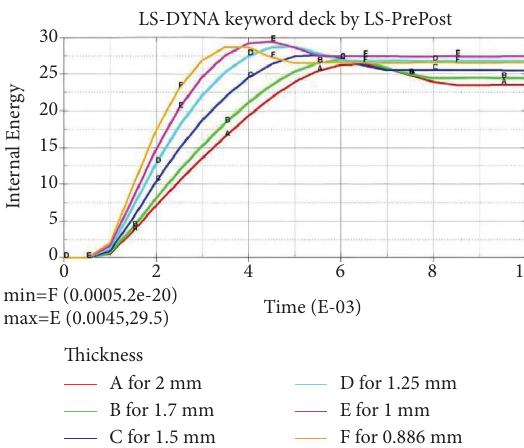
Figure 10: Internal energy with varying thicknesses.